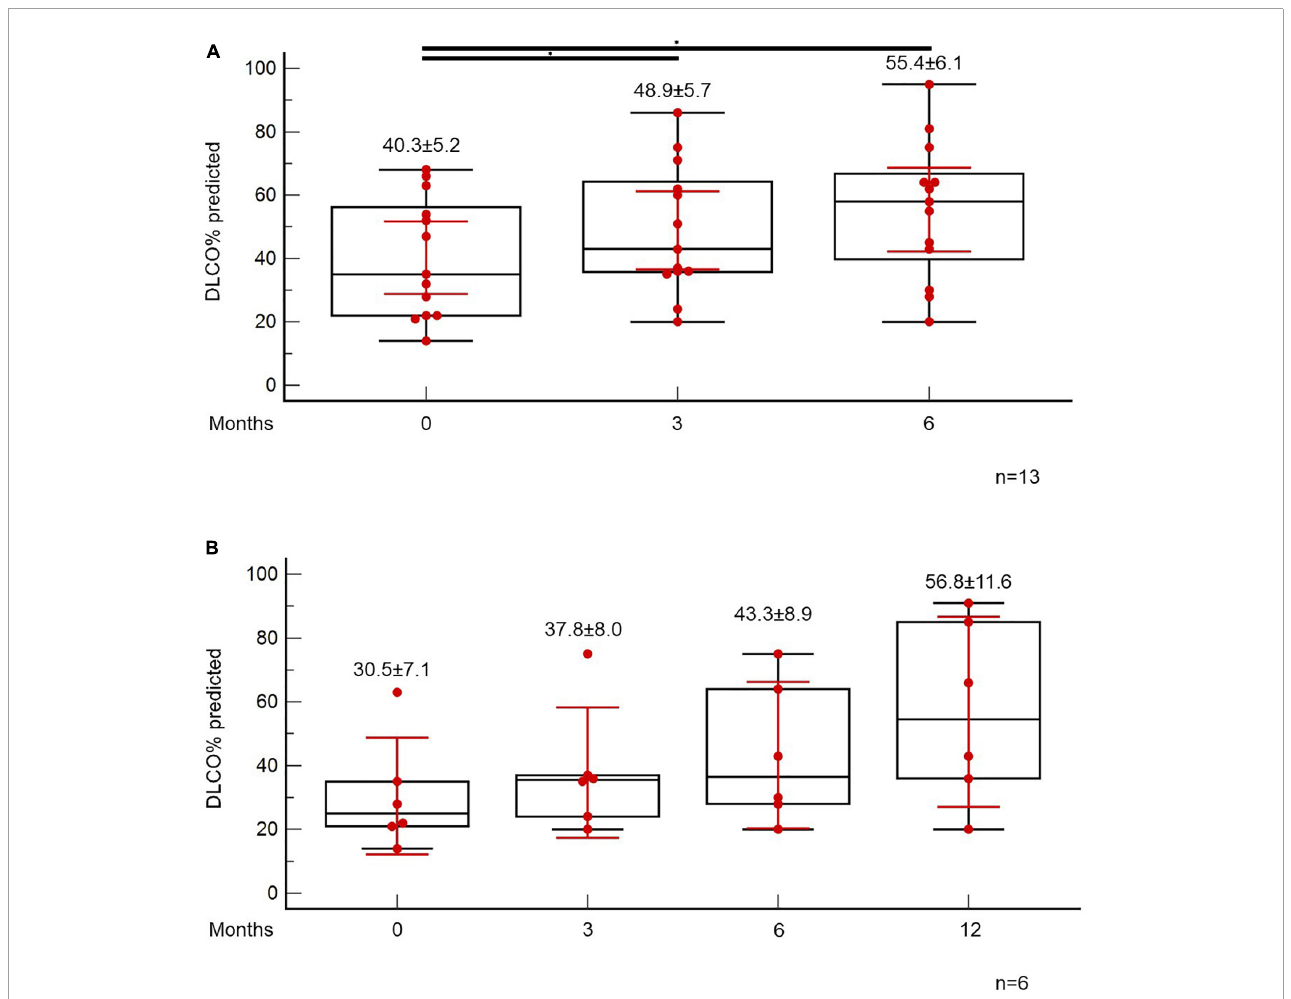
FIGURE6 Patients with fibrotic-like changes and persistently decreased functional indices received antifibrotics. ANOVA repeated measures was used to investigate differences in DLCO% predicted at different time points (A) . Subgroup analysis of patients with 1-year follow-up is presented in panel (B)